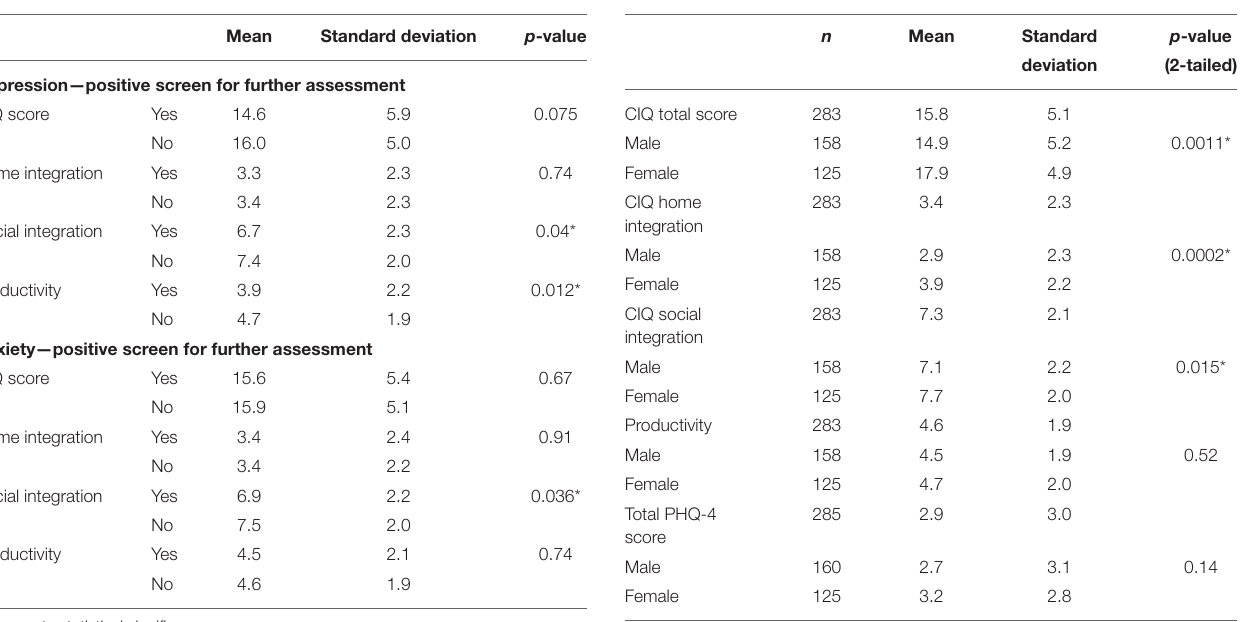
TABLE 2 | Community integration differences by mental health status. TABLE 3.1 | Sex differences in the CIQ and PHQ-4.